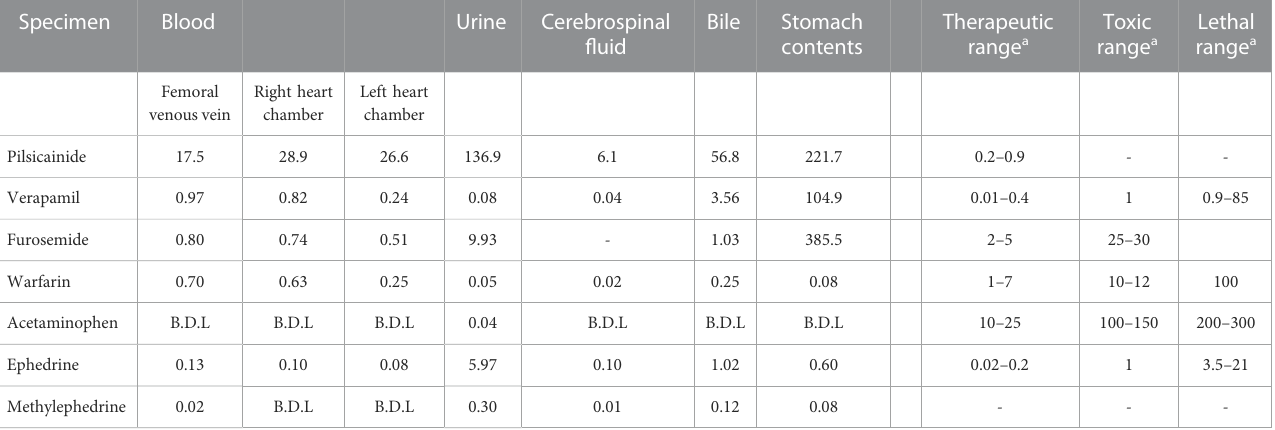
TABLE 1 Concentrations of each drug in the post-mortem samples (µg/mL). Specimen